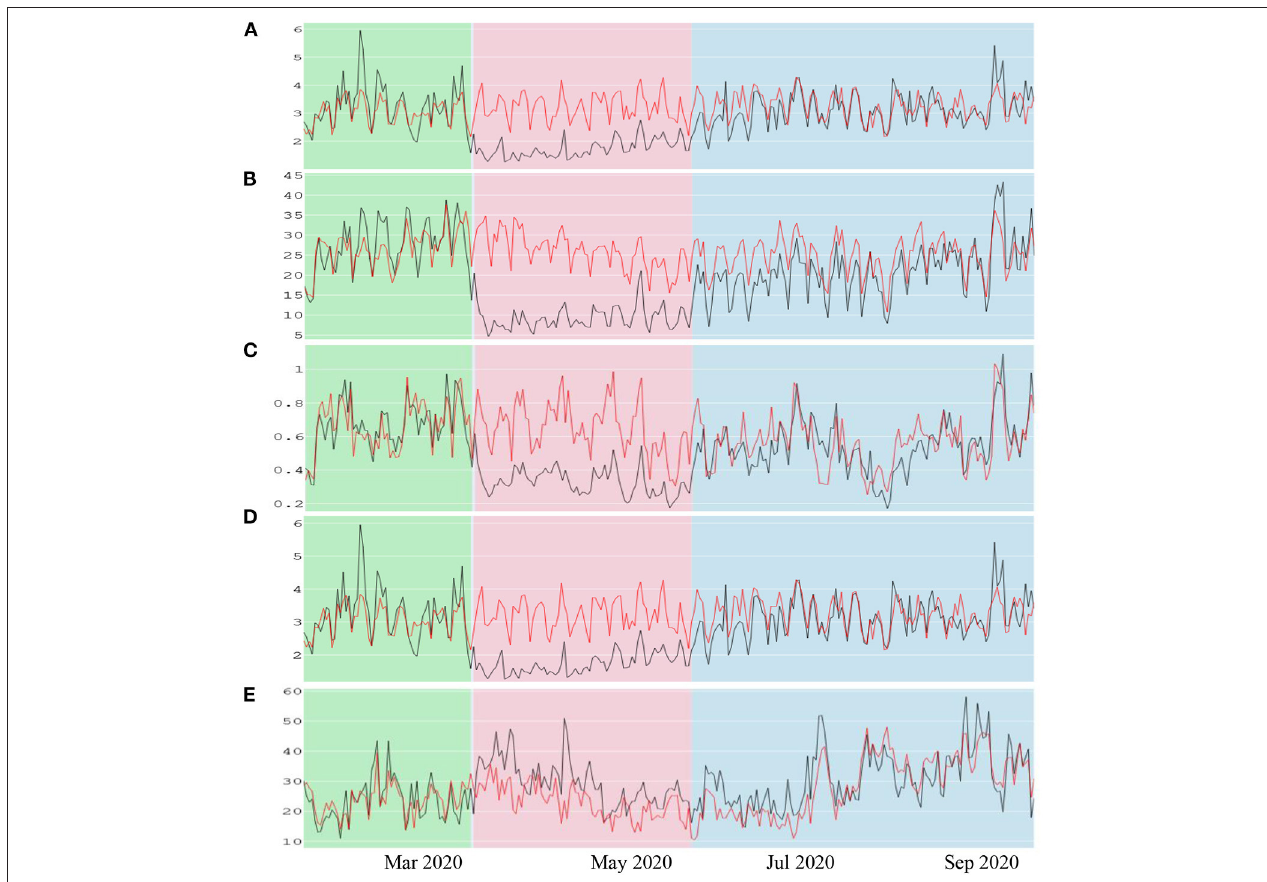
FIGURE 7 | Observed and predicted concentrations of pollutants during the pre-lockdown (green area or validation period), full lockdown (pink area) and partial relaxation (blue area). The black and red lines are the observed and modeled values, respectively. (A) represents PM 2.5 concentrations. (B) represents NO 2 concentrations. (C) represents CO concentrations. (D) represents SO 2 concentrations. (E) represents O 3 concentrations.